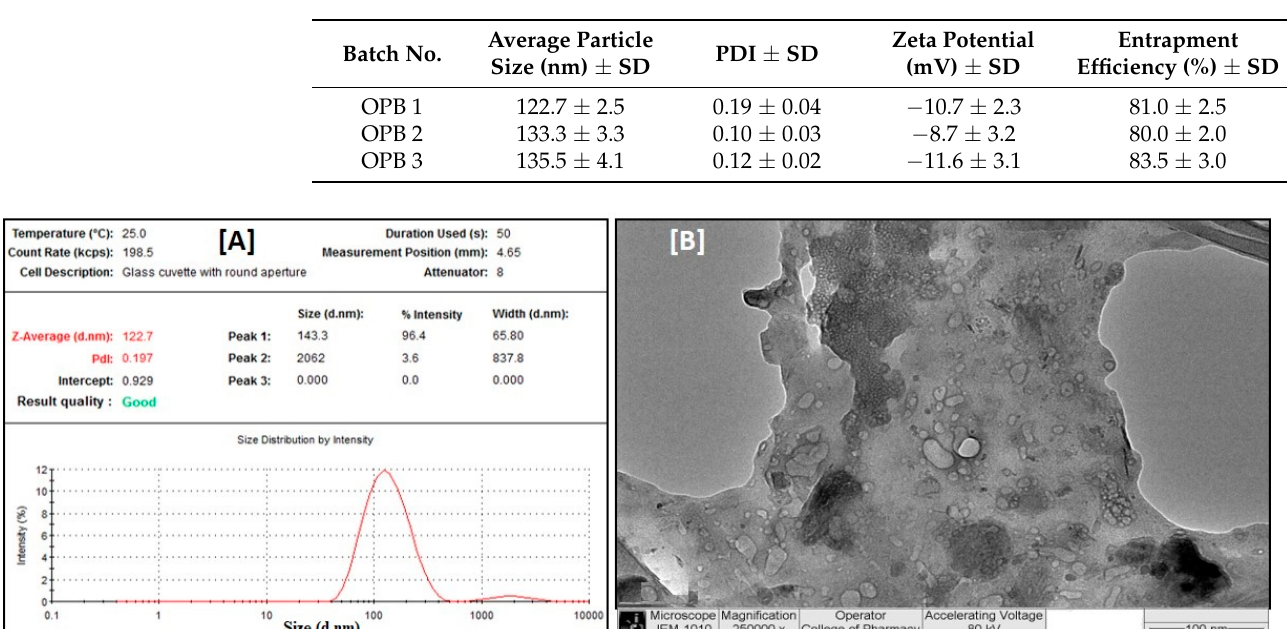
Table 2. Average size, PDI, Zeta potential and entrapment efficiency of three optimized batches of liposomes prepared using similar conditions. Data are presented as mean ± standard error of mean, where n = 6.